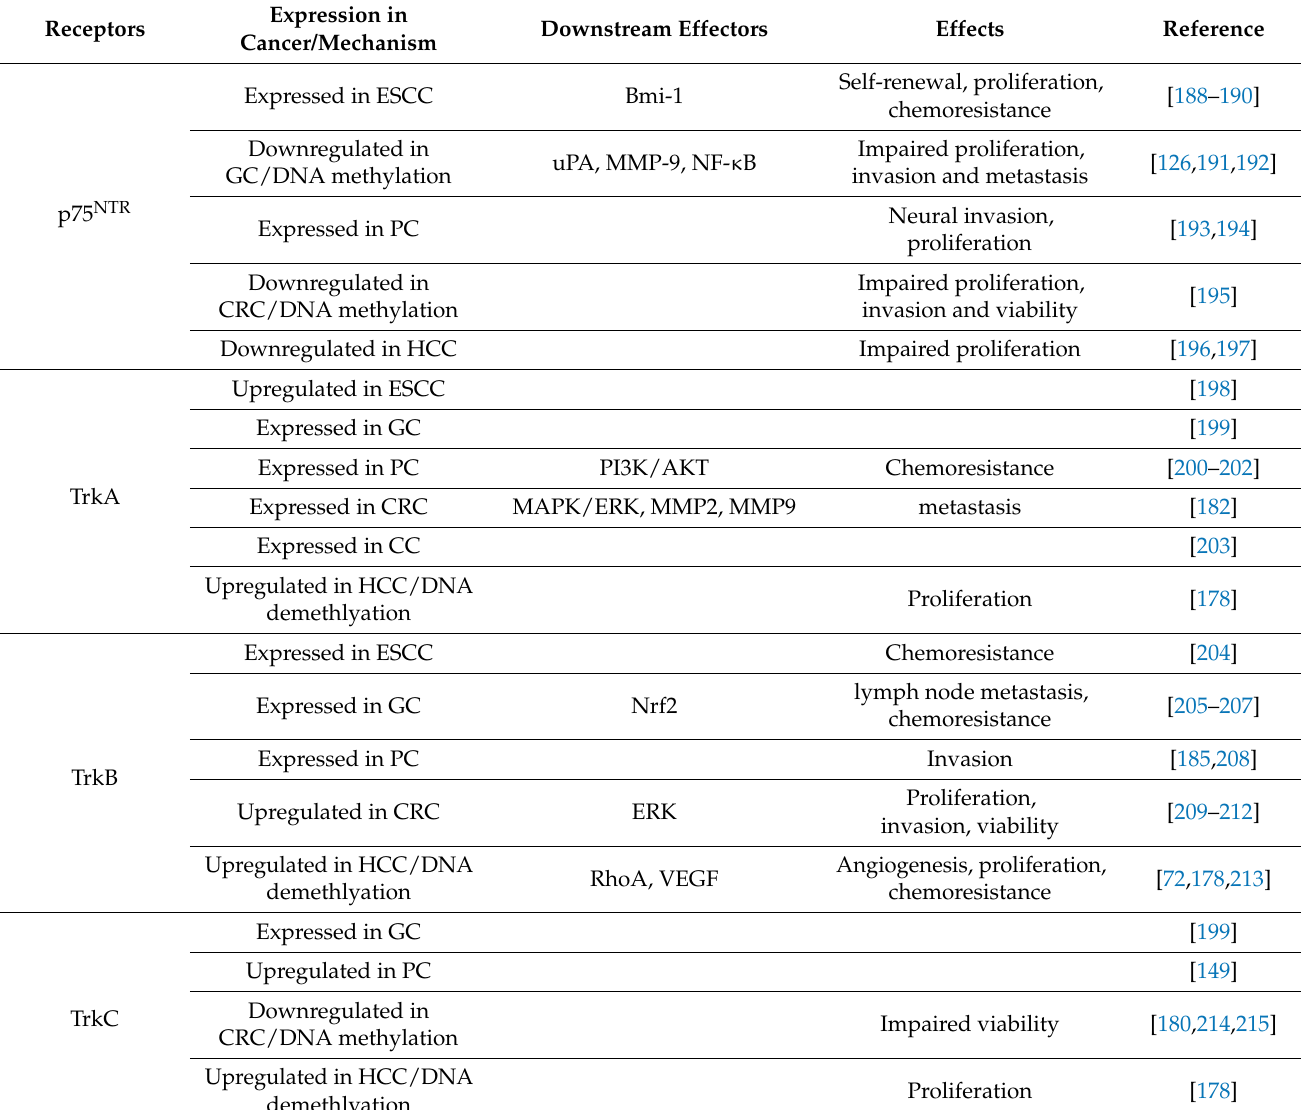
Table 2. The expression and roles of neurotrophin receptors in gastrointestinal